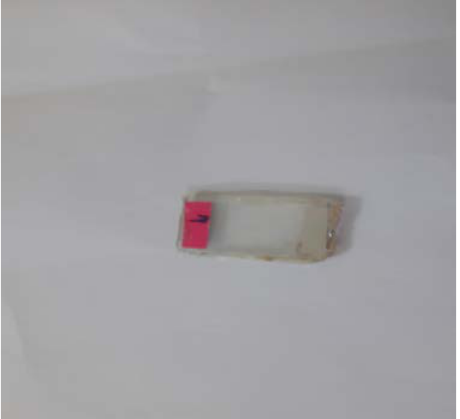
Fig.1: The prepared sample of magnetic